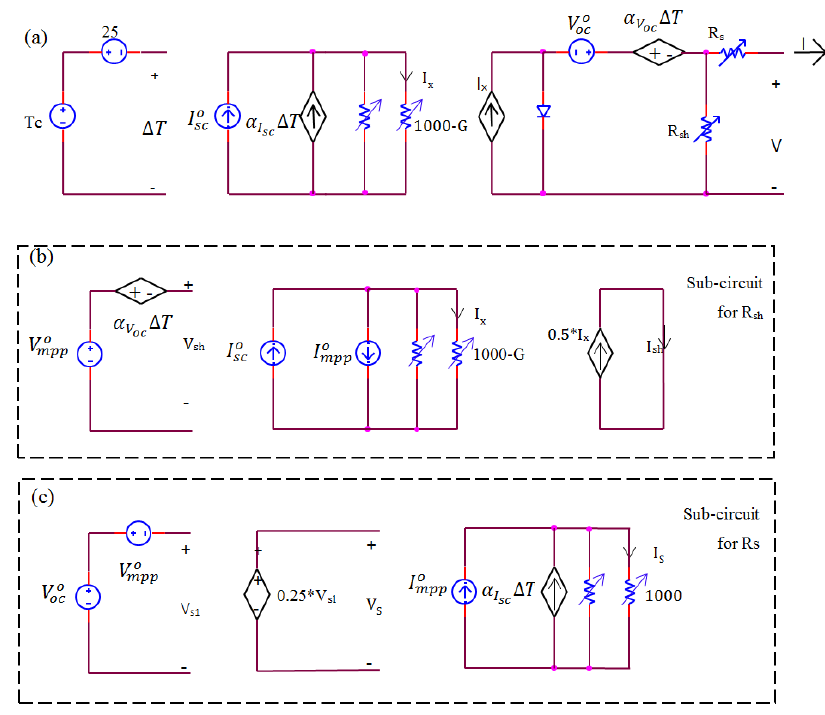
Figure 3. Circuit of a PV cell in any environment